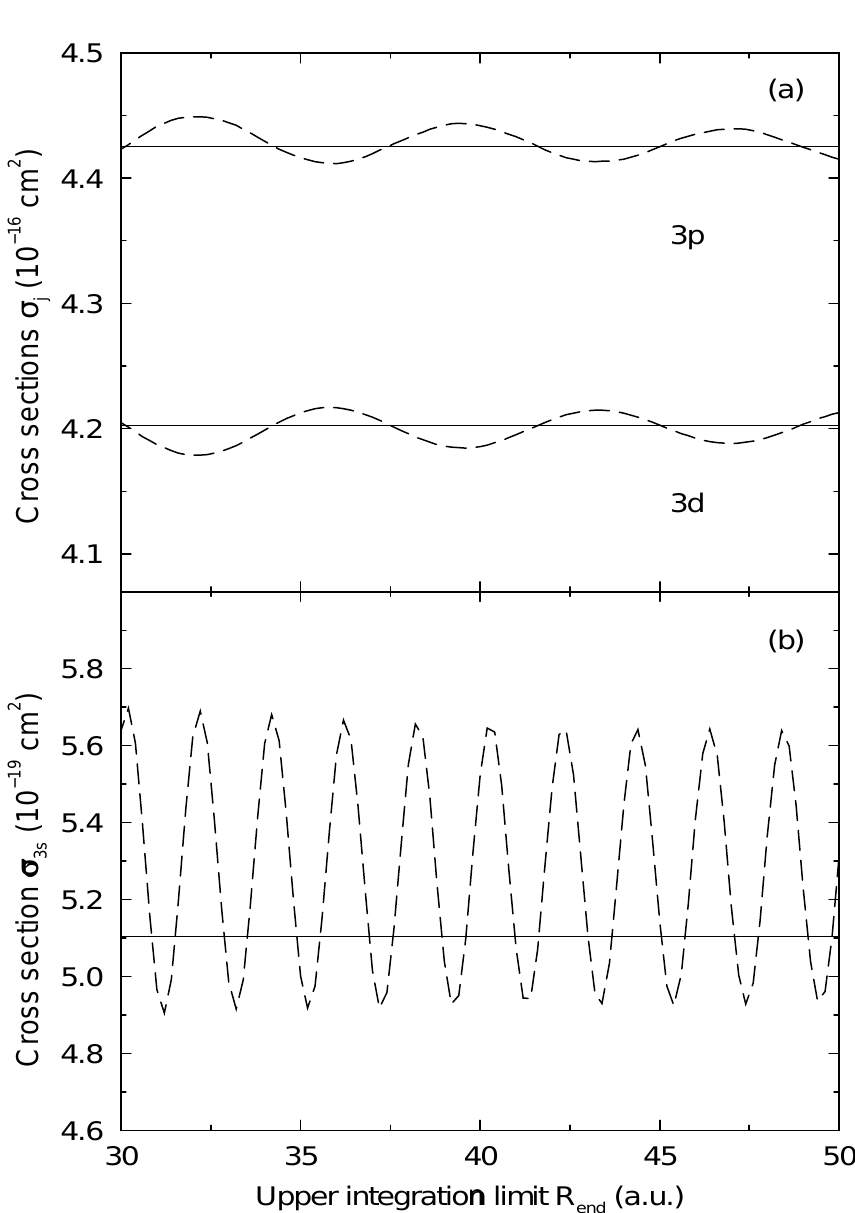
Figure 3: The charge exchange cross sections for excitation of the C 3+ ( nl ) states in D + C 4+ collisions as functions of the upper integration limit R for the collisional energy E = 10 eV/amu. end The solid lines are the results obtained by means of the t/τ -matrix approach, the dashed lines are calculations with the neglection of the electron translation ( τ ± =